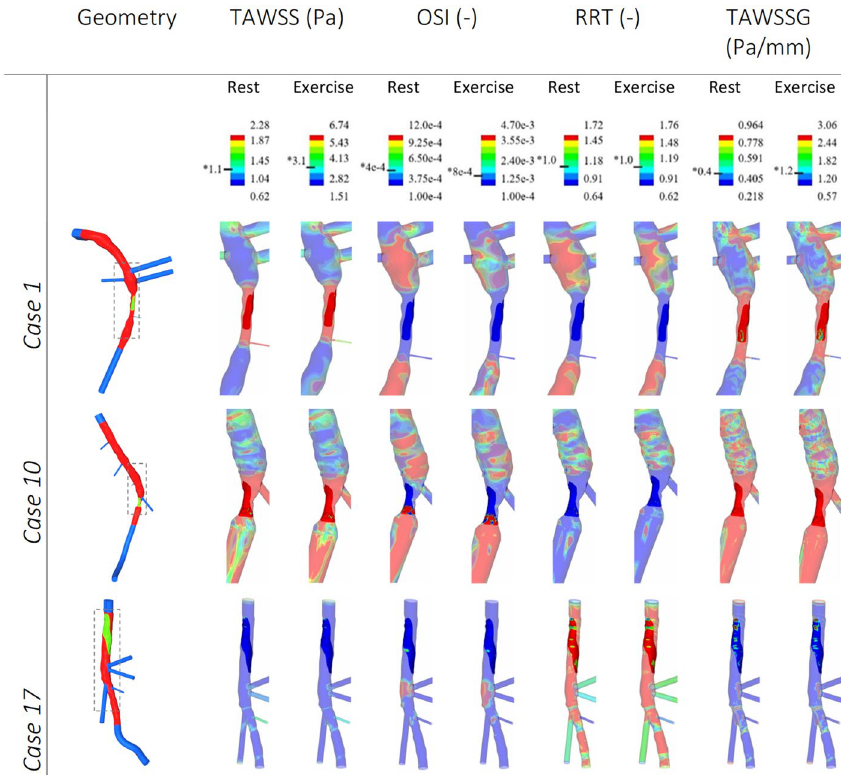
Figure 3. Reconstructed lumen geometries of the LAD, LCX and RCA arteries. Haemodynamic metrics were extracted from CFD simulations. Spatially averaged Time-Averaged Wall Shear Stress (TAWSS), Oscillatory Shear Index (OSI), Relative Residence Time (RRT) and Time-Averaged Wall Shear Stress Gradient (TAWSSG). Both ‘rest’ and ‘exercise’ flow rate conditions were simulated. The thrombus is the opaque portion of the metrics, whilst the remainder of the lumen is semi-transparent. Flow is from top to bottom for all images. Minimum and maximum values for the legends are the lower and upper quartiles of the respective metrics averaged across the rest and exercise cases separately, as shown in Table S4 & Table S5. RRT ranges are normalised with respect to the averaged median RRT at the ‘non-diseased’ location, with the median values being 1.11 and 0.43 for rest and exercise respectively (see “Supplementary data S1” for full results). Ensight 10.2.3, was used to post-process and visualise the results. *The median value for the respective